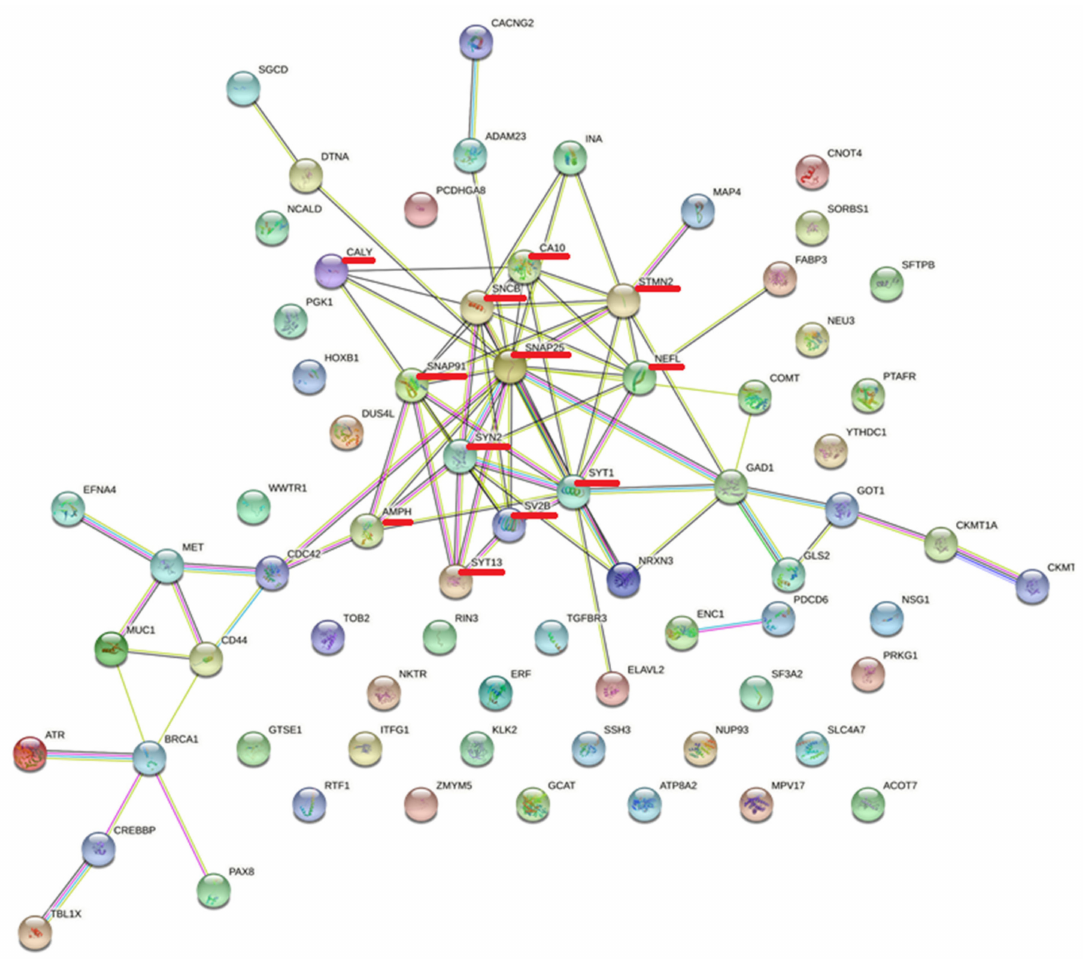
Figure 6. Protein–protein interactions of 76 consensus differentially expressed genes in Alzheimer’s disease. Twelve genes identified with MCODE are